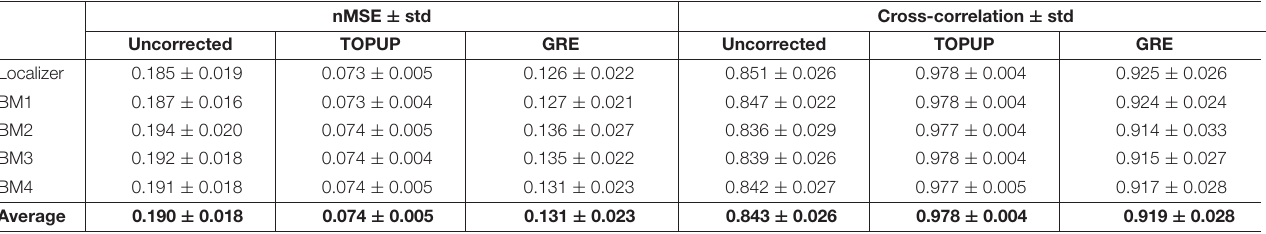
TABLE 3 | Differences of the corrected PA and AP images between distortion correction approaches quantified in terms of the nMSE and cross-correlation, averaged across participants (and voxels, in the case of the nMSE), and across runs. nMSE ± std Cross-correlation ± std PA AP PA AP Localizer 0 . 117 ± 0 . 009